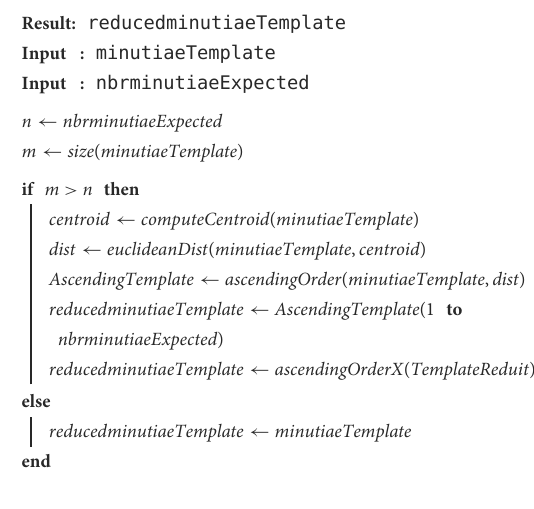
Algorithm 3. Barycenter method.